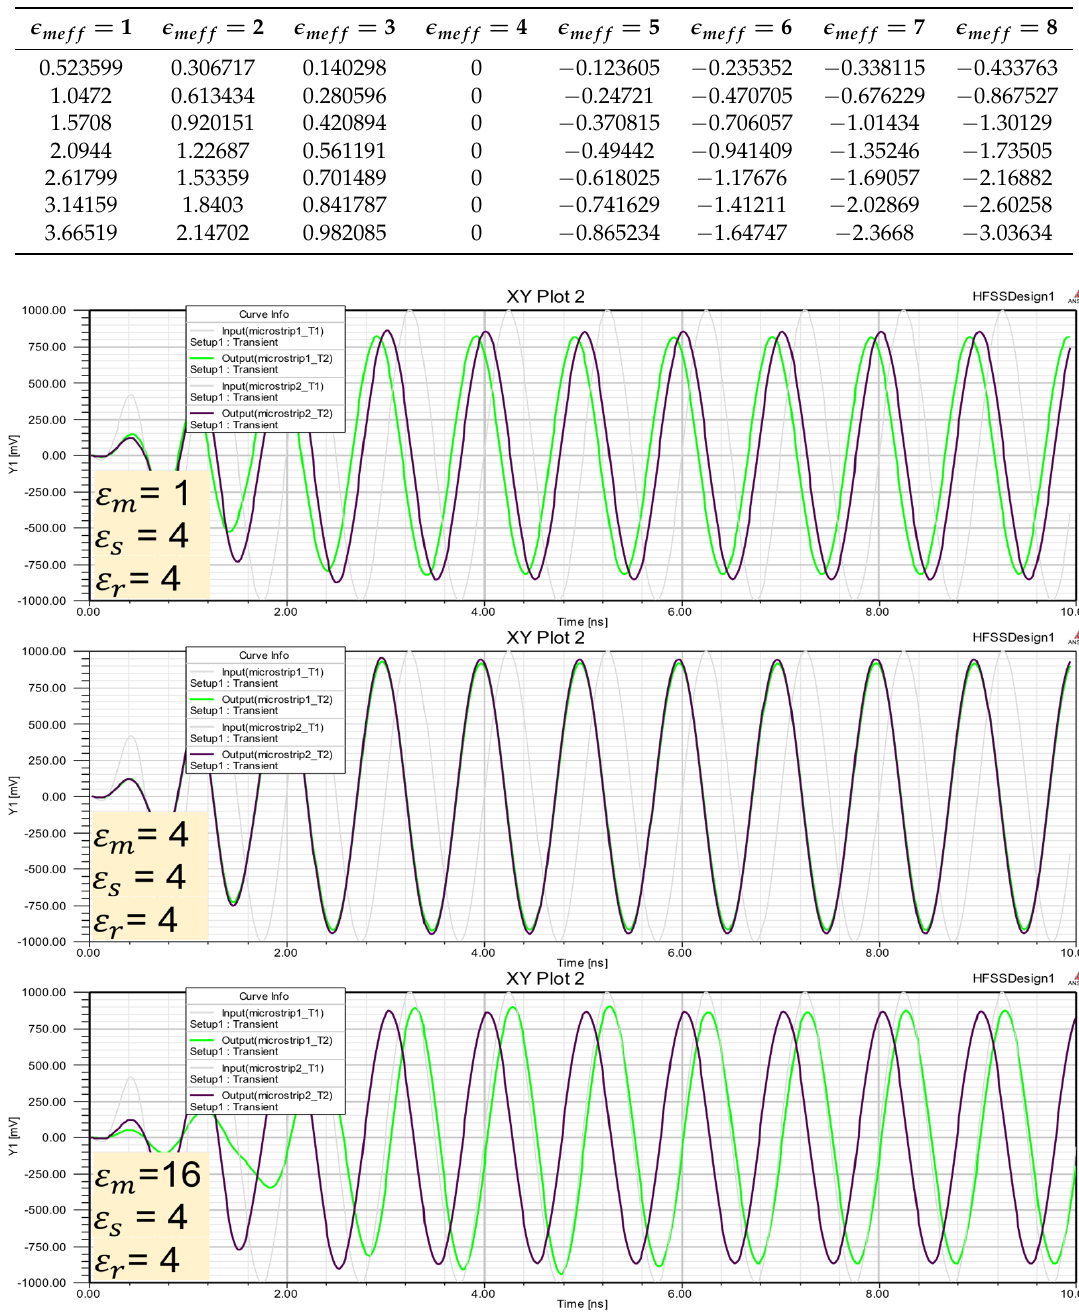
Figure 12. Microstrip line simulation with reference and substrate permittivity (cid:101) r = 4. Different permittivity medium (cid:101) m are used to obtain phase shift on microstrip